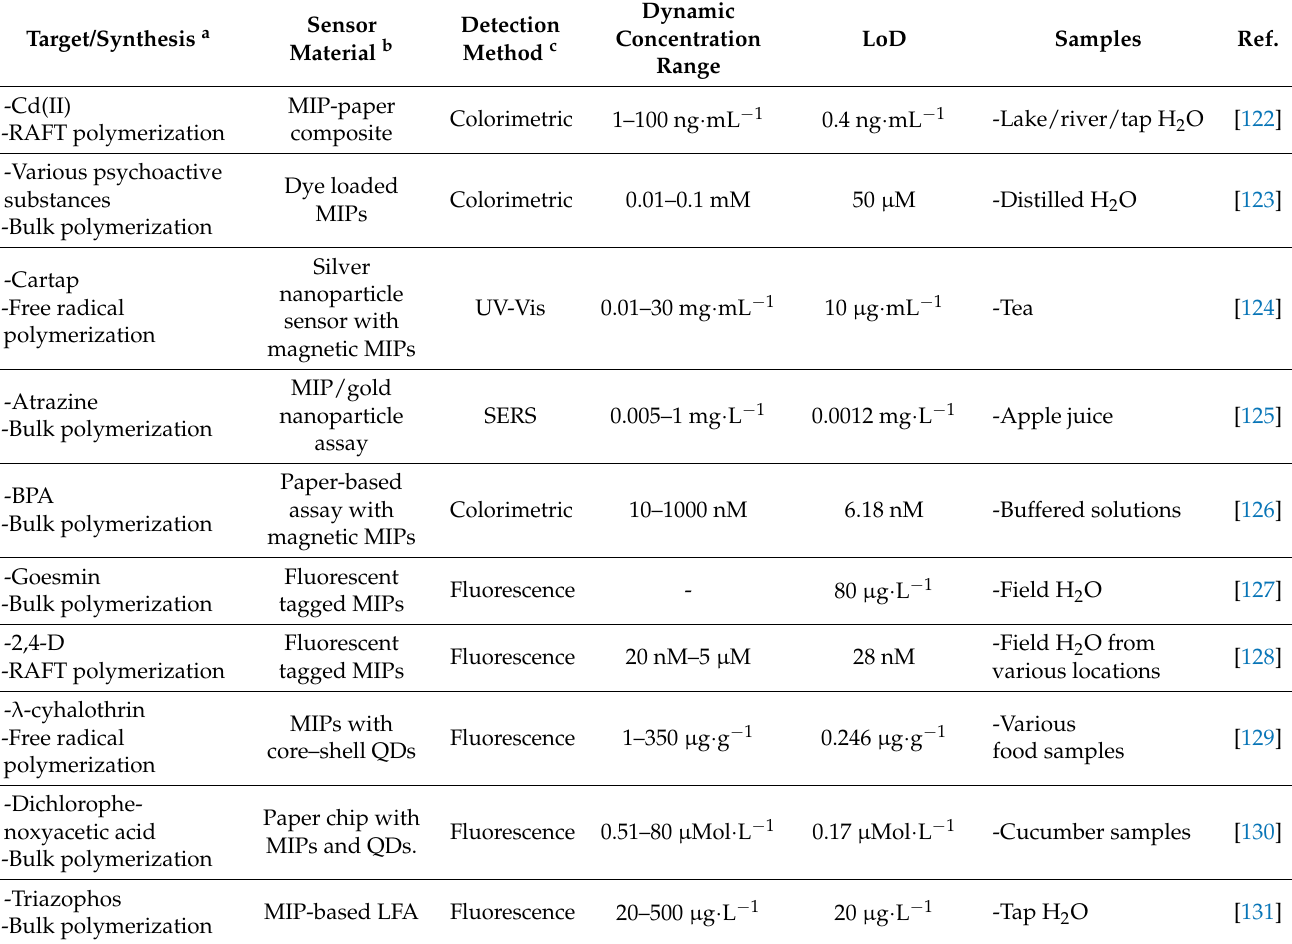
Table 5. Summary of studies which have utilized MIPs for the optical detection of various